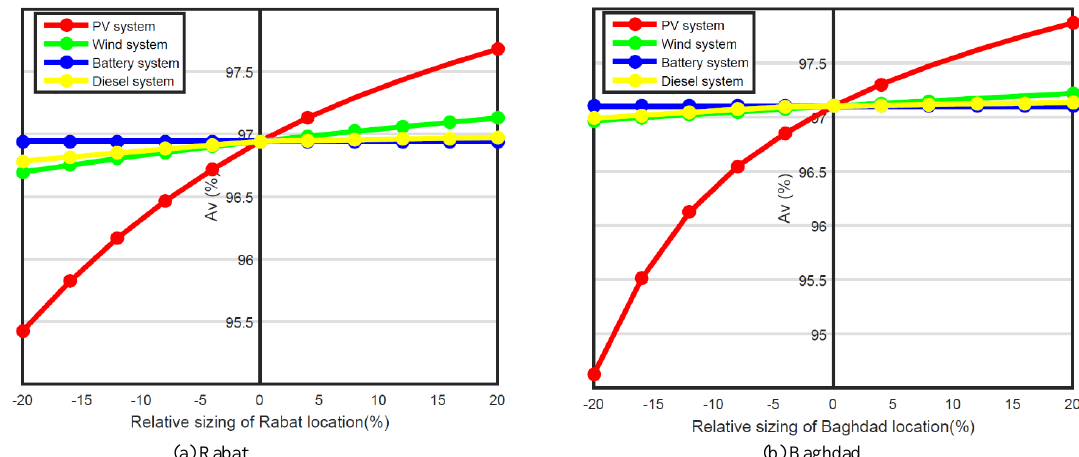
Figure 12. Sensitivity analysis of availability